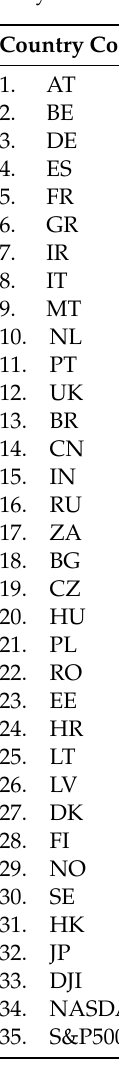
Table A5. Country code and name of the country for the stock